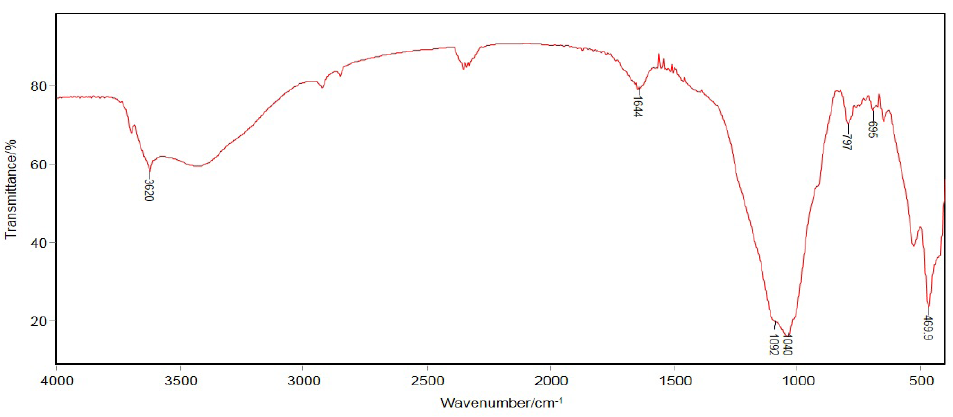
Figure 3: IR spectrum of raw